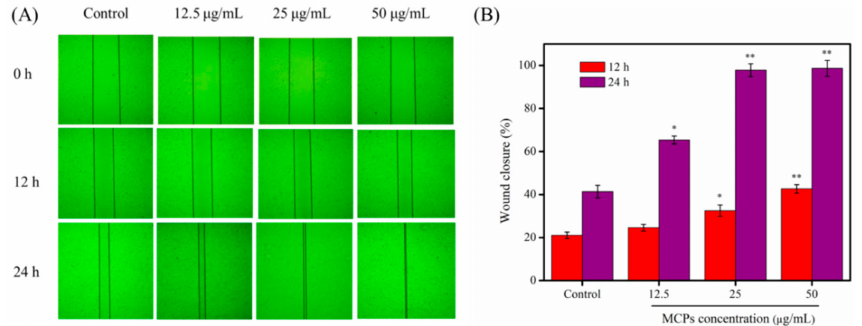
Figure 5. Effect of MCPs from Nibea japonica skins on the scratch closure in vitro. ( A ) Representative optical images showed the cells migrated toward wound gap after 12 h and 24 h incubation; ( B ) Wound closure rate (%) that affected by MCPs for 12 h and 24 h. The data was obtained by using Image J 1.38 software and were expressed as the mean ± standard deviation ( x ± s , n = 6). * p < 0.05 and ** p < 0.001 vs.